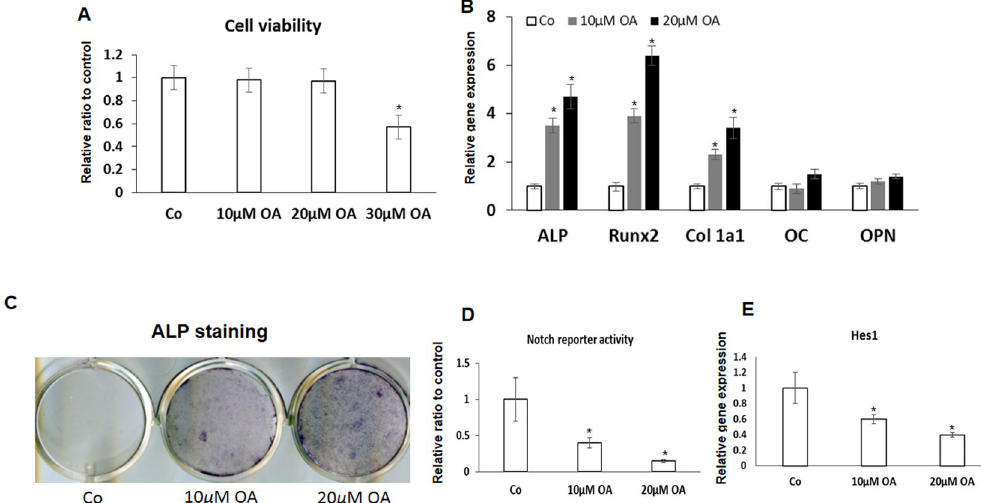
Figure 1. Inhibition of Notch signaling by OA enhances inducted MSCs osteogenic differentiation. ( A ) Cell viability assays showed a significant increase of cell death was only observed in high dose of OA (30 µ M) treatment for 12 hours. ( B ) Quantification of gene expression of osteogenic markers indicates a significant increase (p < 0.05) of early stage markers of ALP, Runx2, and type I collagen (Col1a1); and no significant change was observed in expression of later markers Osteocalcin (OC) and Osteopontin (OPN). Data is the means ± s.d. of three independent experiments performed in duplicate and the shRNA-lentivirus control (Co) gene expression level was set at 1. ( * p < 0.05 compared with control) ( C ) An increase in osteogenic nodule formation was observed in OA treated MSCs at day 7, with maximal staining of OA treatment at 20 µ M. Scale bars, 100 µ m. ( D ) Luciferase assays showed a significant decrease of Notch responsive reporter activity in OA treated MSCs in a dose dependent manner. Data is the means ± s.d. of three independent experiments performed in duplicate and all the results were normalized to internal control ( * p < 0.05 compared with control MSCs (Co) without OA treatment). ( E ) Real time PCR data showed a significant decrease of Notch target gene Hes1 expression at day 7 following OA treatment compared to DMSO treated control MSCs